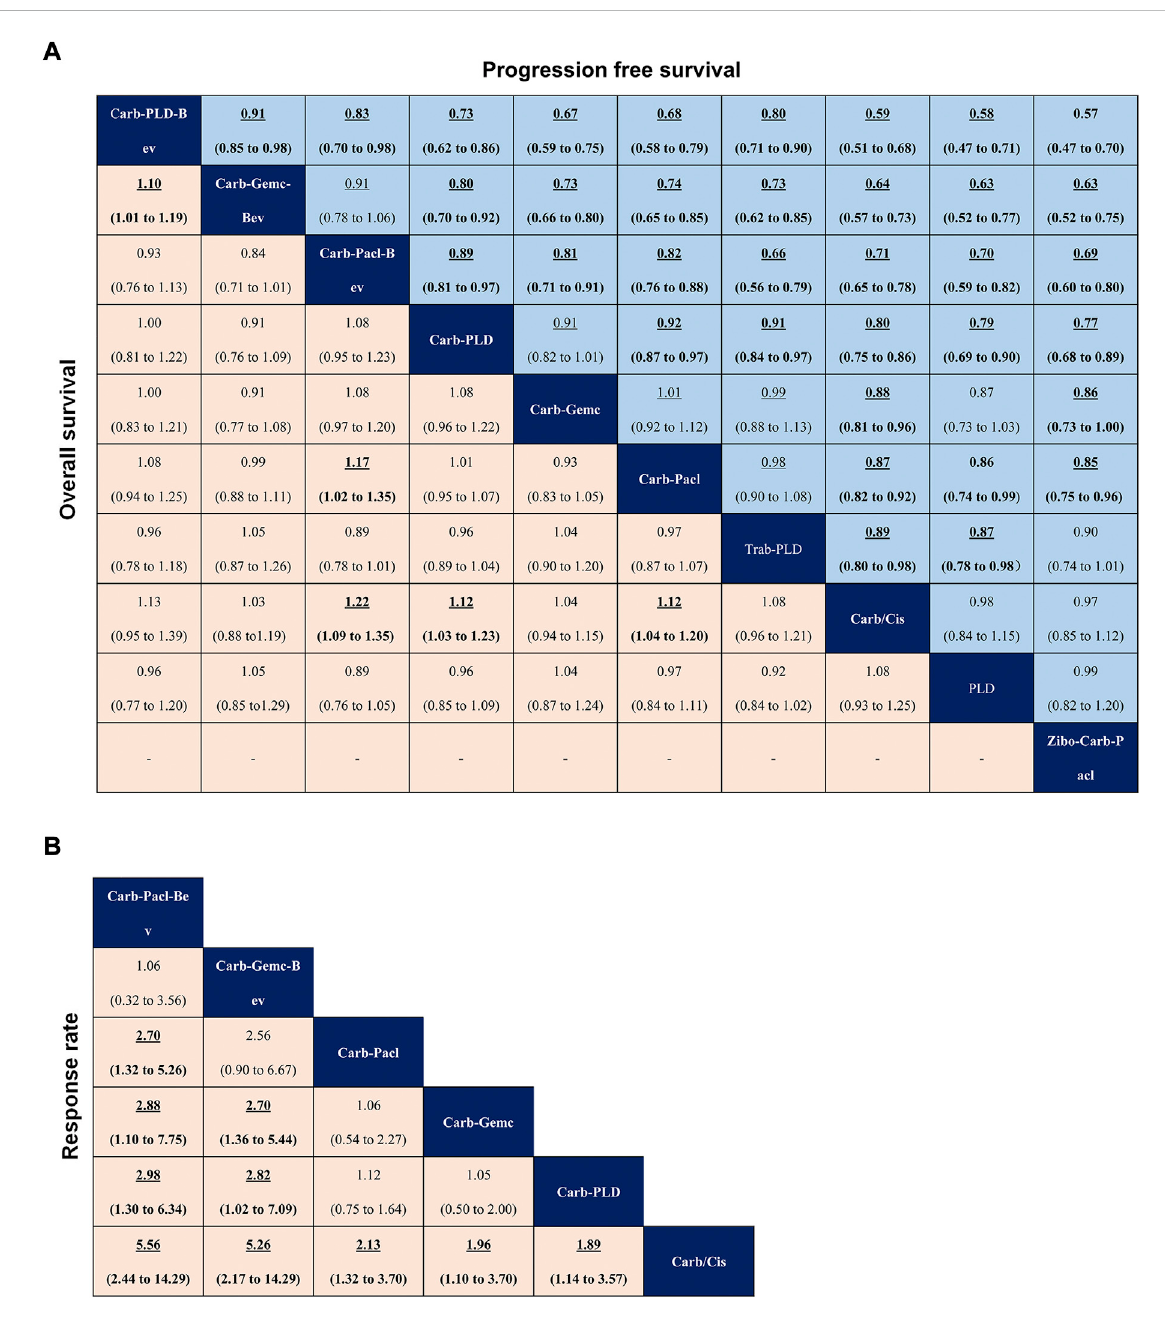
FIGURE 4 Pooled estimates of initial treatments in the network meta-analysis. (A) Data are hazard ratios for progression-free survival (upper triangle) and overallsurvival(lowertriangle). (B) Oddsratiosforobjectiveresponserate.Datawithhazardoroddsratiosrepresentthecomparisonofrow-de fi ning treatment versus column-de fi ning treatment. Data in parentheses are the 95% credible intervals. Hazard ratios less than one and odds ratios more than one favour the row-de fi ning treatment. Signi fi cant results are highlighted in bold and